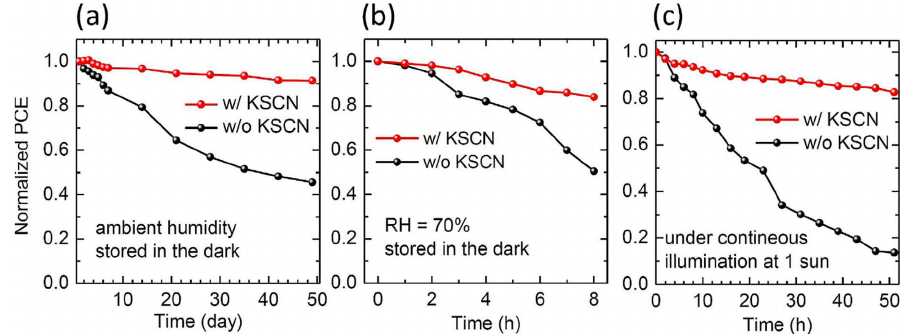
Figure 10. Time-dependent PCE of PSCs depending on post-treatment with KSCN at different condition of ( a ) ambient atmosphere with low humidity (the devices kept in the vacuum chamber in the dark before and after measurements), ( b ) relative humidity (RH) of 70% and ( c ) continuous illumination under one sun (the devices were encapsulated). Reproduced with permission from Reference [76]. Elsevier 2019.